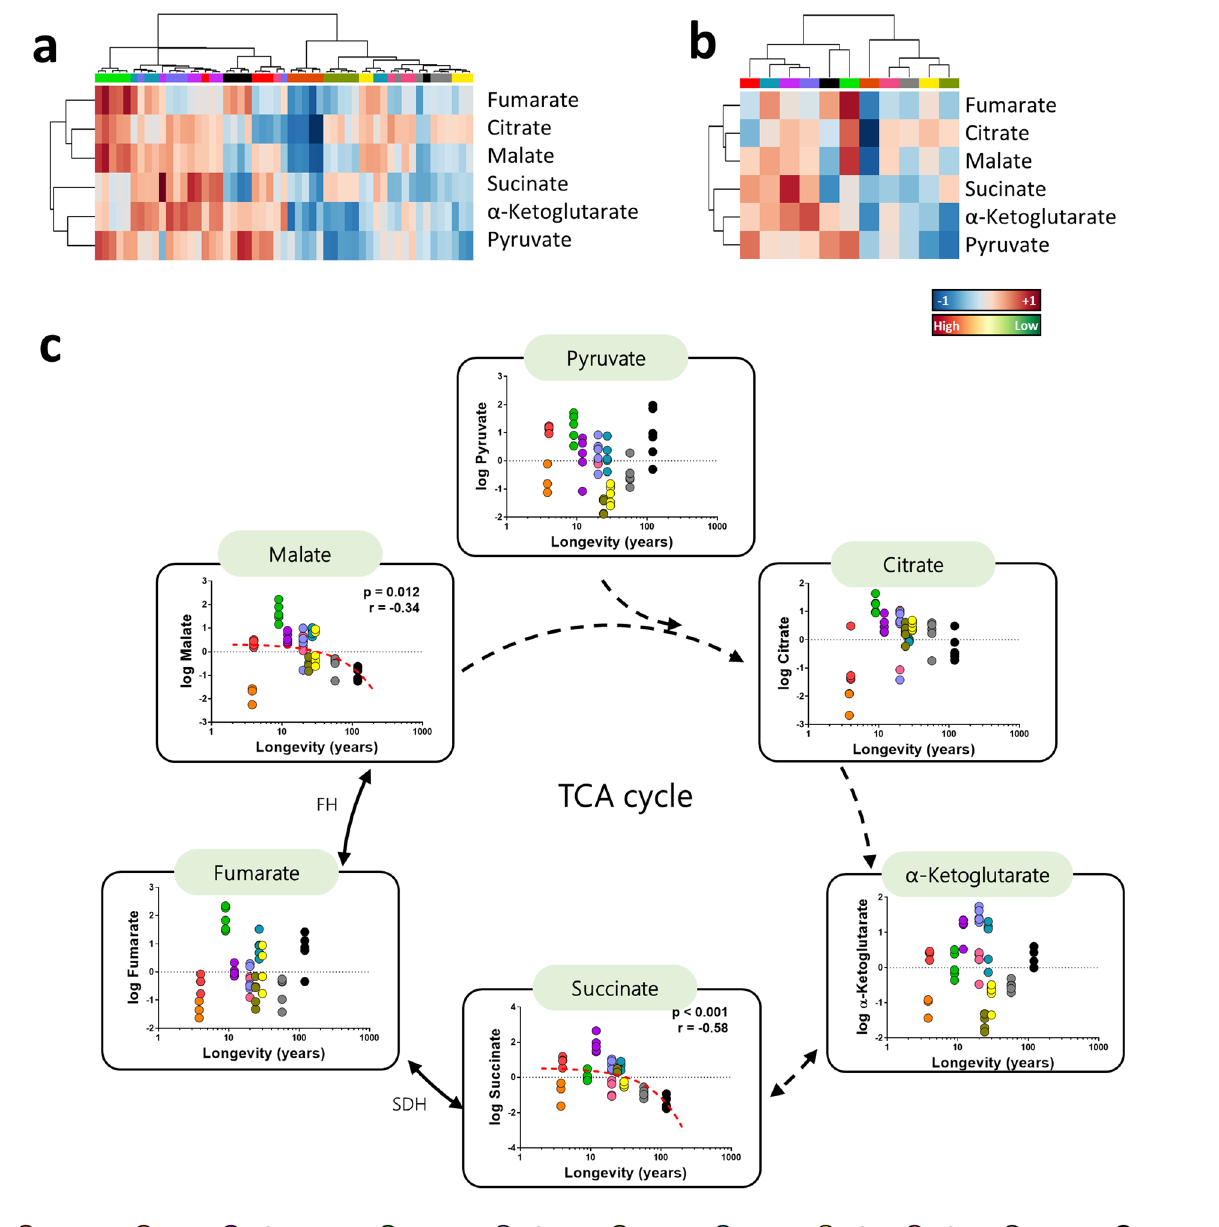
Fig. 5 Multivariate statistics reveals a shared TCA cycle intermediates plasma pro fi le. a Hierarchical clustering of individual animal samples according to metabolite abundance. b Hierarchical clustering animal species according to average metabolite abundance. c Individual plasma correlation of the metabolites with animal longevity involved TCA cycle. Dashed lines refer to reactions in which more than one enzyme is involved. Pearson correlation between plasma metabolites and animal longevity was performed. Minimum signi fi cation level was set at p < 0.05. All metabolites were log-transformed in order to accomplish the assumptions of normality. Data values are obtained from four (mice and cows), fi ve (rats, rabbits, guinea pigs, sheep, dogs, pigs, cats and horses) or six (humans) specimens. Enzyme codes refer to: SDH or Cx II succinate dehydrogenase, FH fumarate